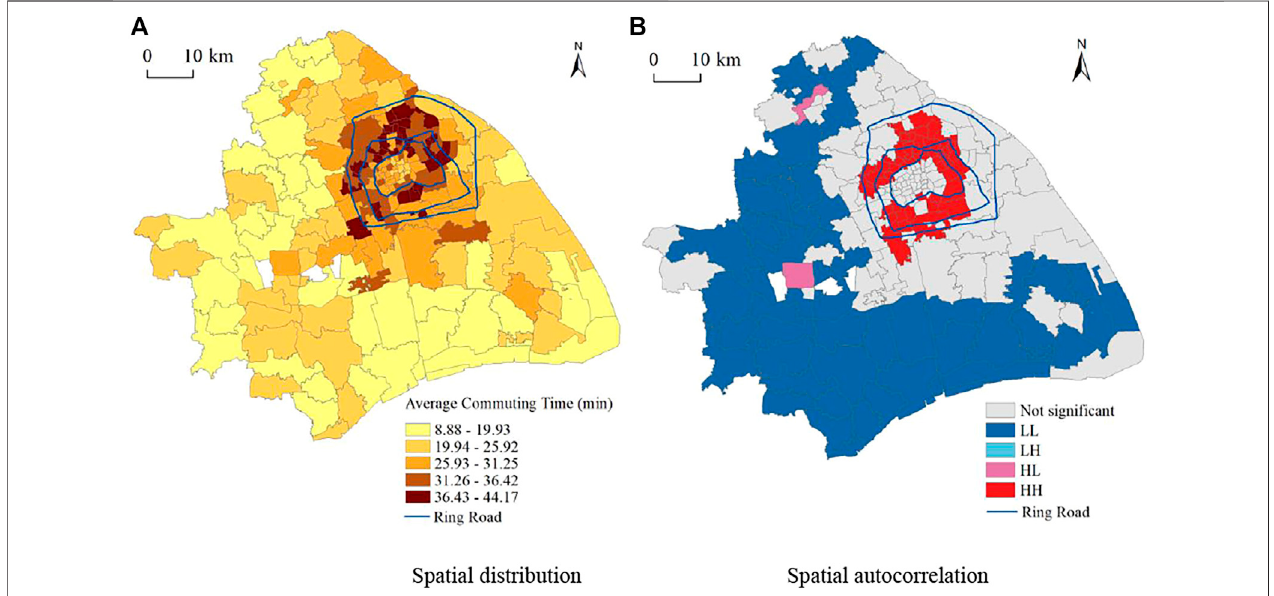
Frontiers in Built Environment |